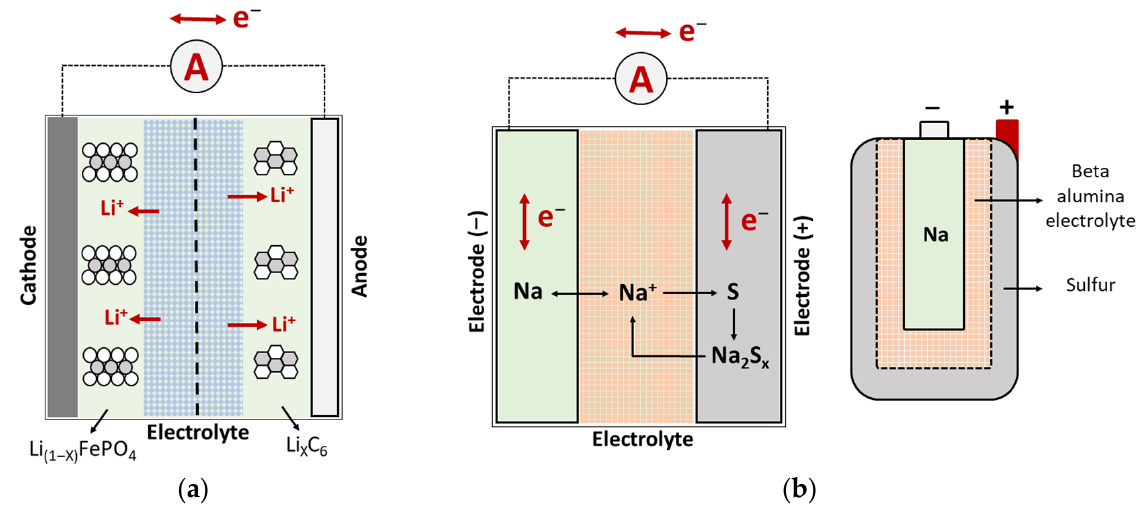
Figure 8. Composition of battery cell from current (( a ): Li-ion LFP type cell) and future generation (( b ): Na-S cell).